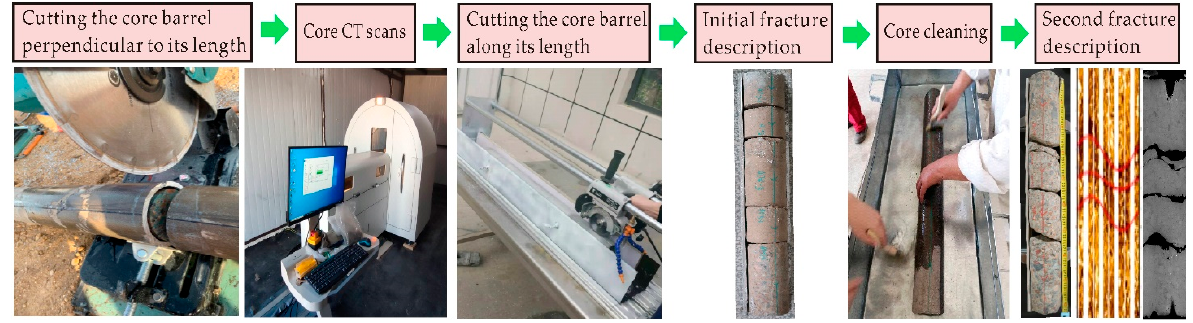
Figure 4. Workflow chart of the slant core methods: handling and process for core